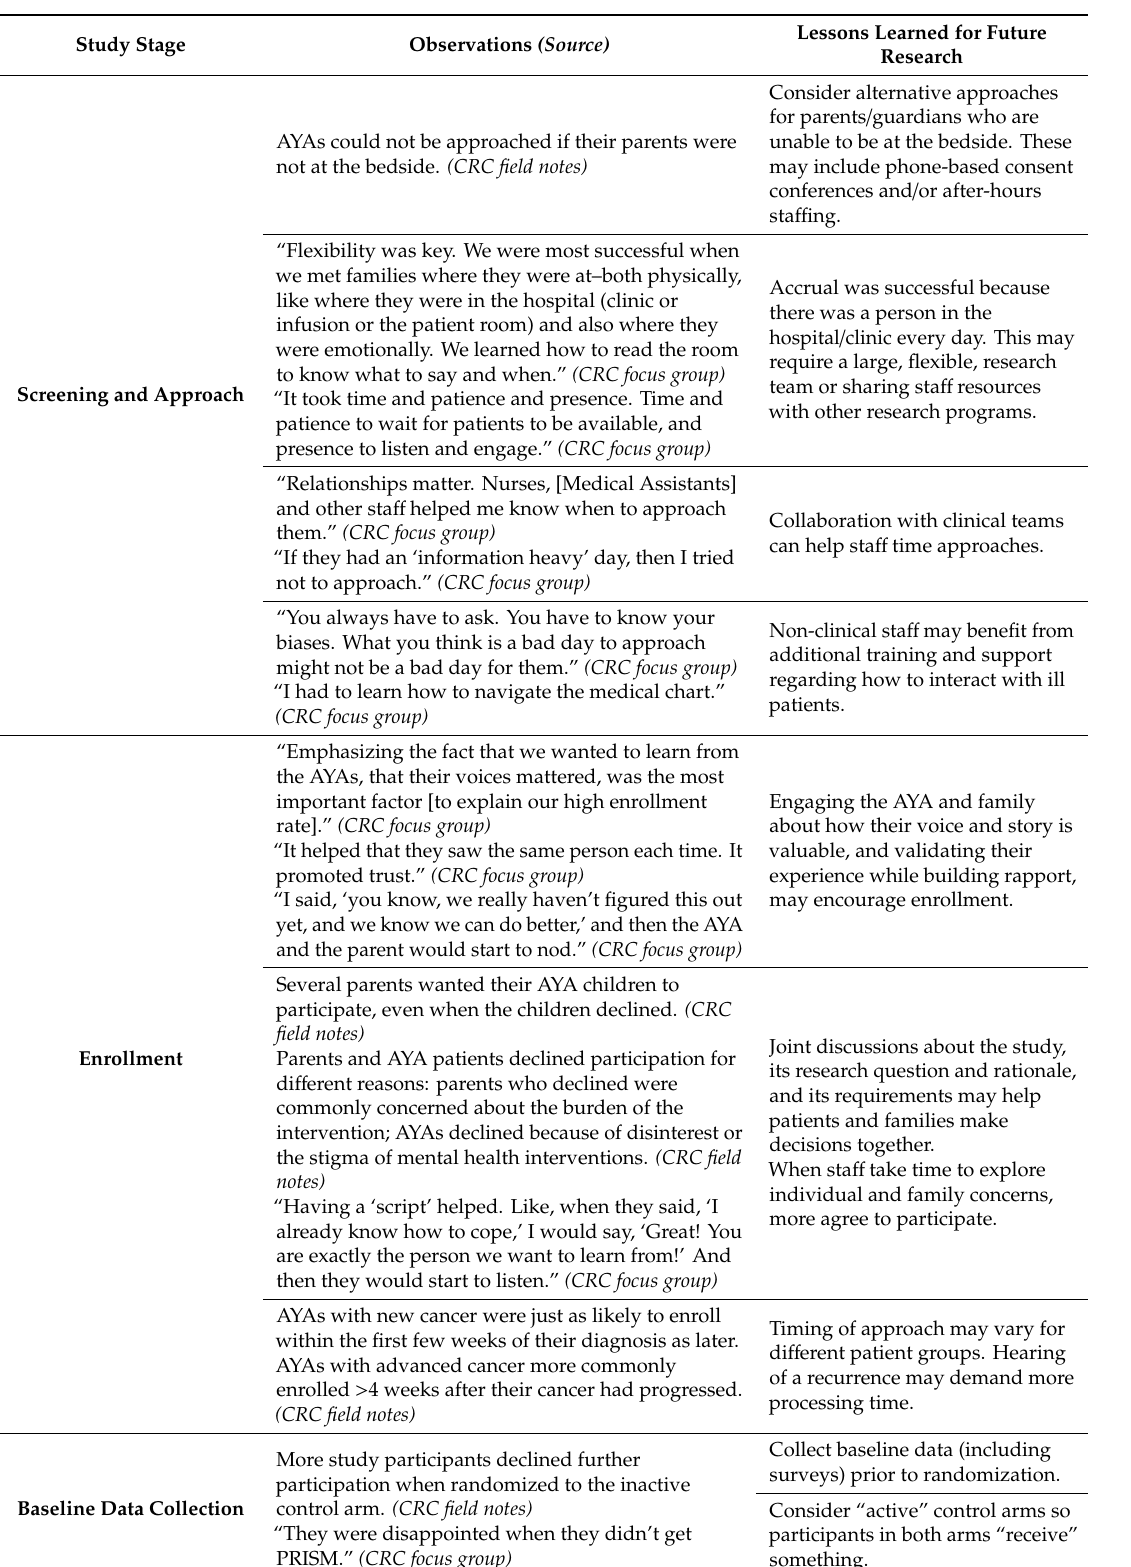
Table 4. Observations by study stage and lessons learned for future